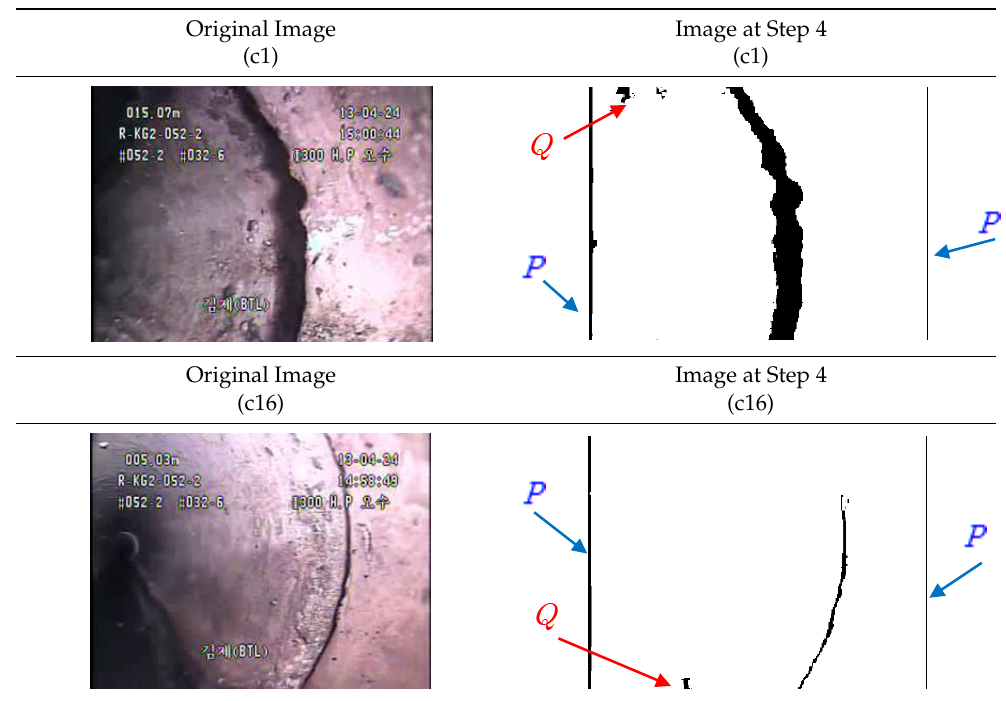
Table 8. Application of the user algorithm.